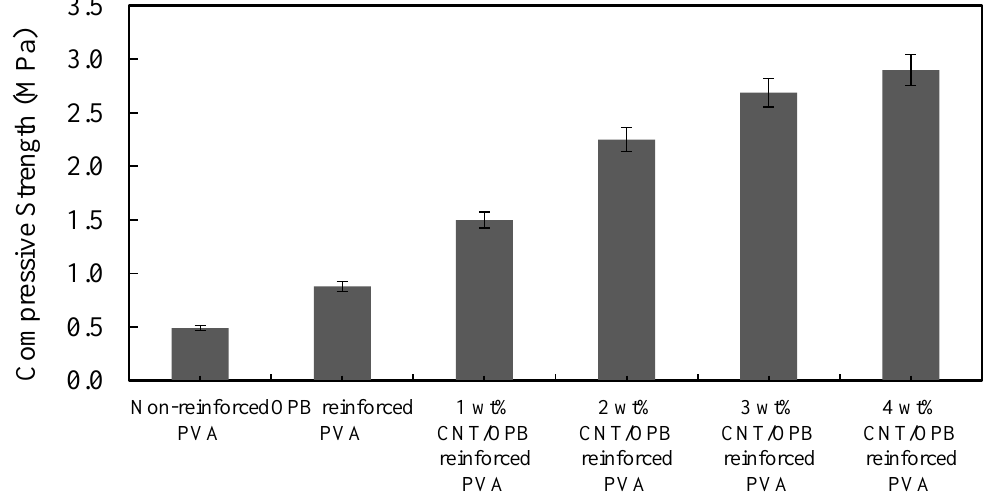
Figure 5. Compressive strength of all water swollen hydrogels at different amount of MWCNTs. Experimental conditions: cross-sectional area of samples = 20 mm 2 , at room temperature.